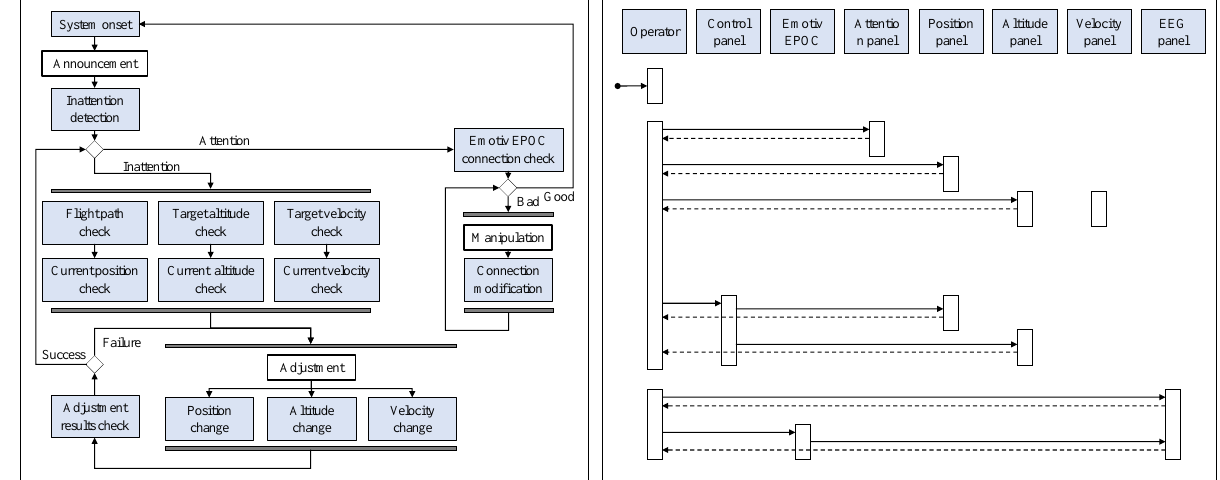
Figure 7. User sequence diagram ( right ) and flow chart ( left ) of the proposed attention recovery system.